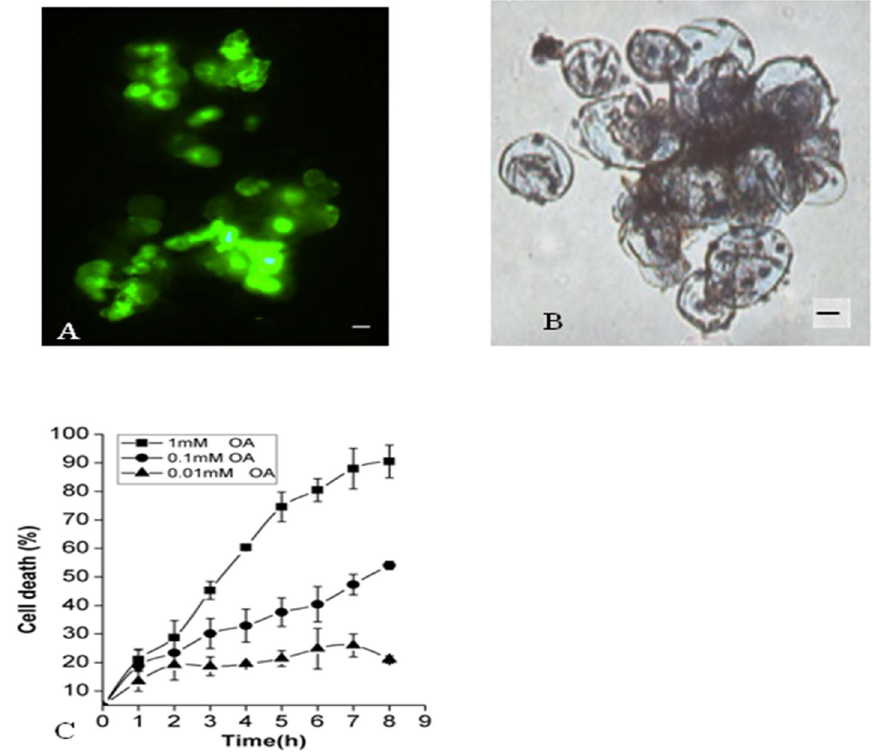
Figure 1. Effects of oxalic acid on P. tunicoides suspension cell viability. Cells were treated with 0.1 mM OA for 8 h, stained with FDA ( A ). and with 1 mM OA for 8 h, stained with Evans blue ( B ), Effect of different concentrations of OA on cell viability from 0 to 8 treatment ( C ). Bar = 10 µm. Values are expressed as means ± SEM.